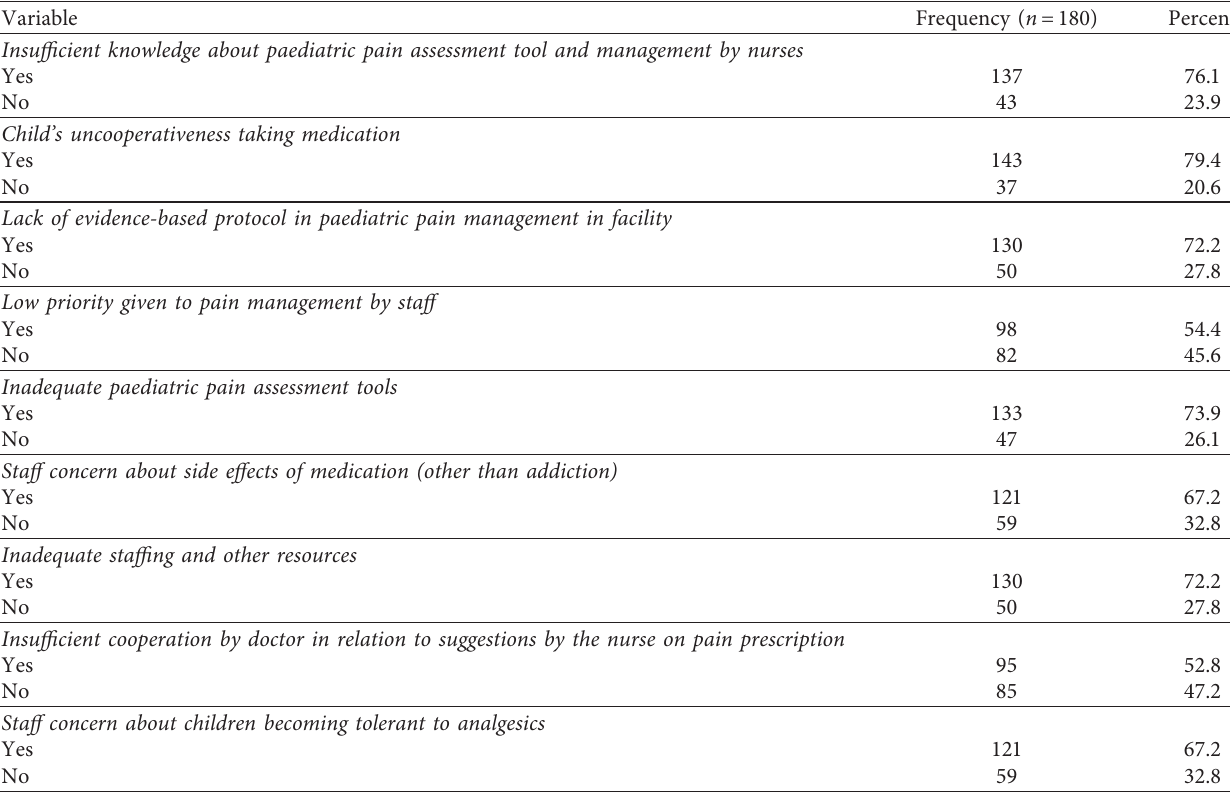
Table 6: Barriers related to paediatric pain